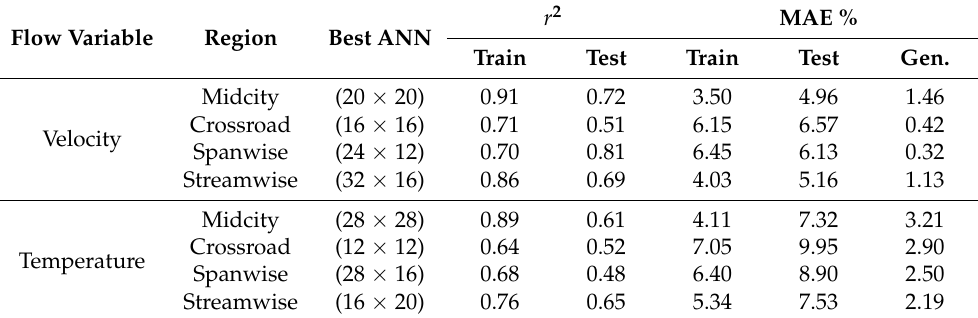
Table 7. Cubic polynomial profile prediction with ANN for velocity and temperature.